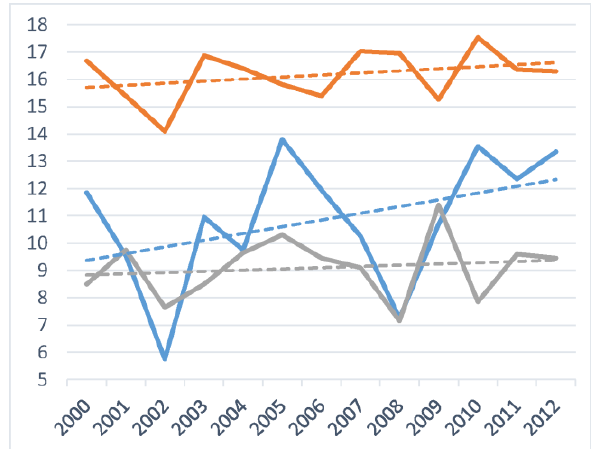
Figure 2. Graphs of the air temperature (̊C) at the Syktyvkar station, from 2000 to 2013. The temperature is averaged by seasons (blue graph – spring, orange – summer, grey - autumn)